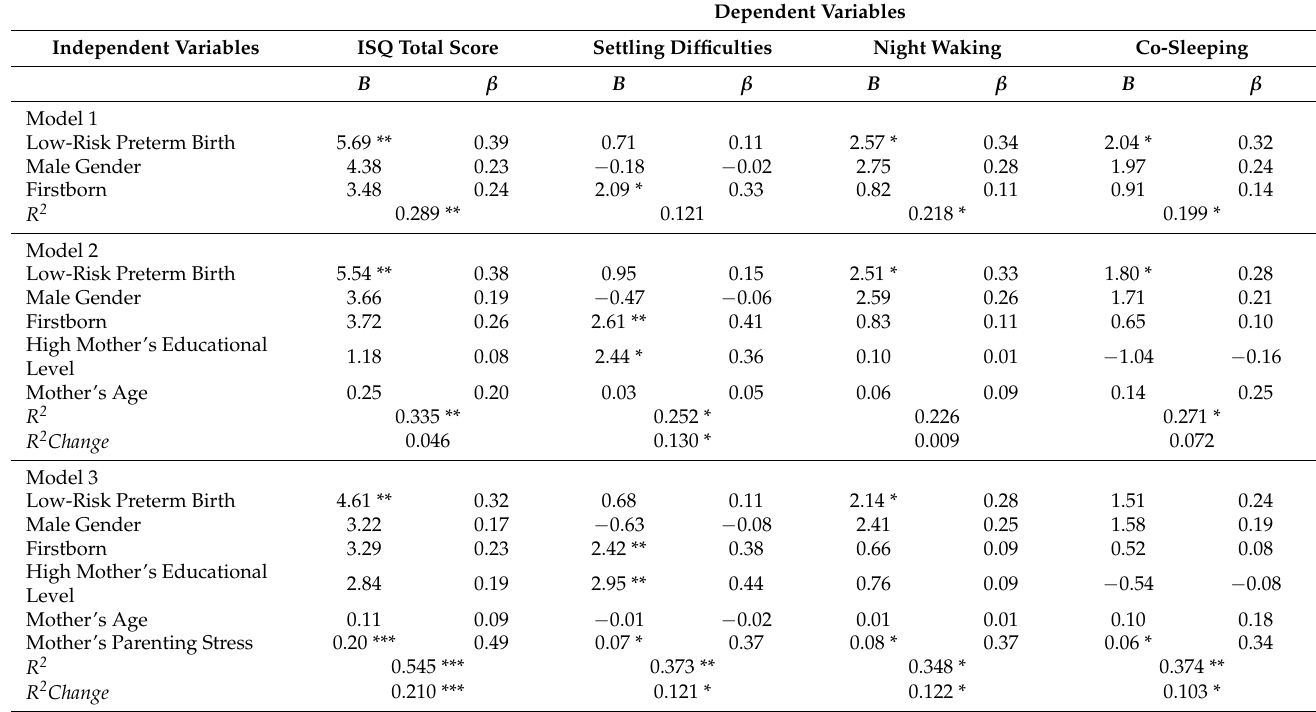
Table 4. Hierarchical Regression Analysis for ISQ Total Score, Settling difficulties, Night Waking and